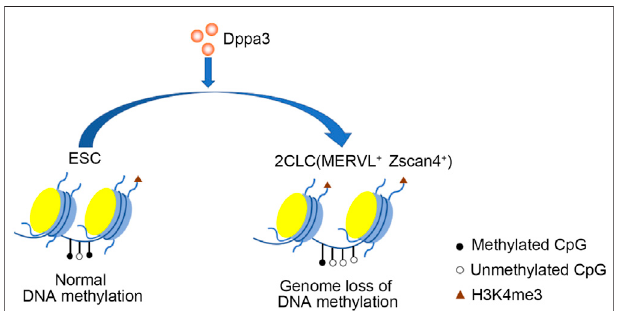
FIGURE 6 | A model illustrating Dppa3-mediated DNA demethylation and 2C-like genes activation in ESCs. Dppa3 promotes chromatin remodeling,DNAhypomethylation, activates 2C-speci fi cgenesandfacilitates 2CLCs